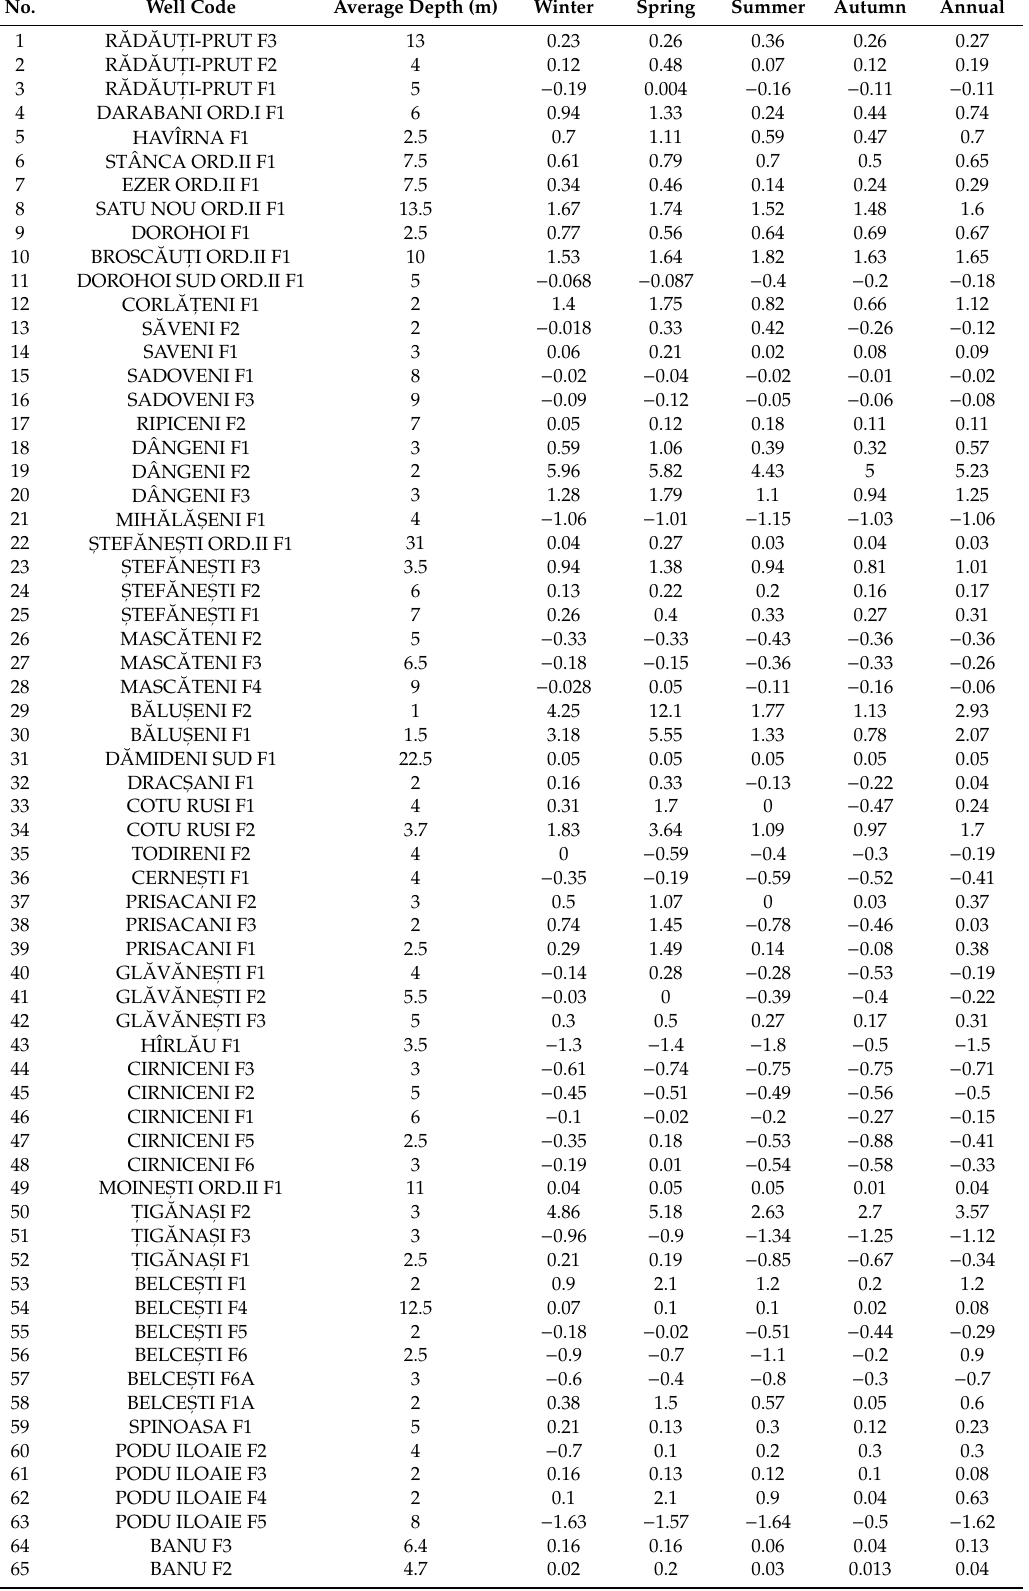
Table 1. Changes in seasons and annual groundwater level according to the ITA